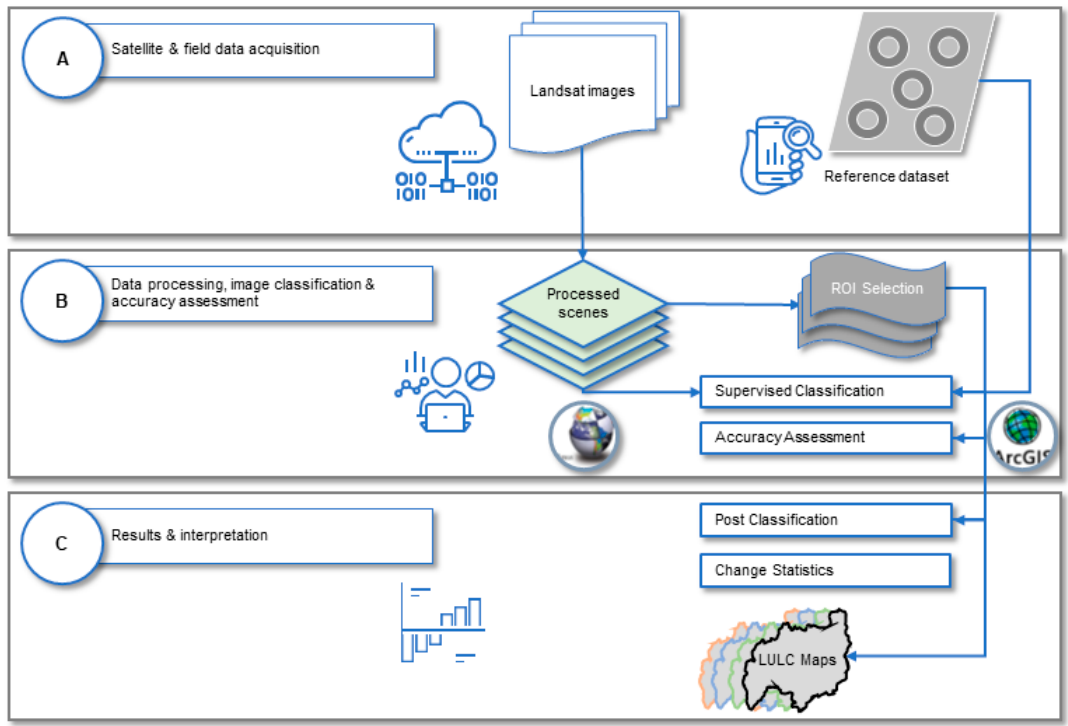
Figure 2. Workflow illustrating the Landsat image processing and analysis to develop land use land cover maps (LULC) for the Lake Victoria Basin (LVB).